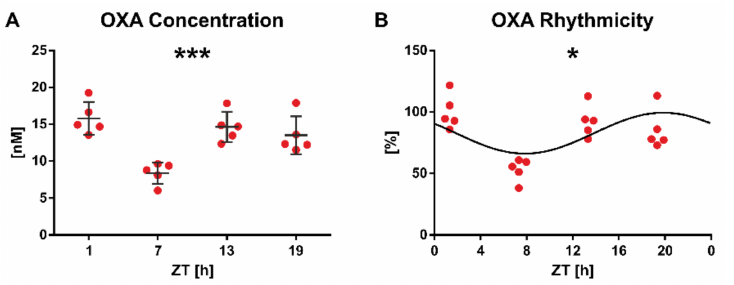
Figure 4. Orexin A (OXA) exhibits daily rhythmicity in the rat vitreous body samples. ( A ) Daily variation in concentration assessed by one-way ANOVA (*** p = 0.0002, n = 20). ( B ) Daily rhythmicity studied with sine wave fitting (* p = 0.049, n = 20; CircWave). Each data point demonstrates an average of three measurements obtained from one vitreous body collected from one animal. %—relative OXA concentration to ZT1 average. ZT—Zeitgeber time. Data are presented as a mean ±